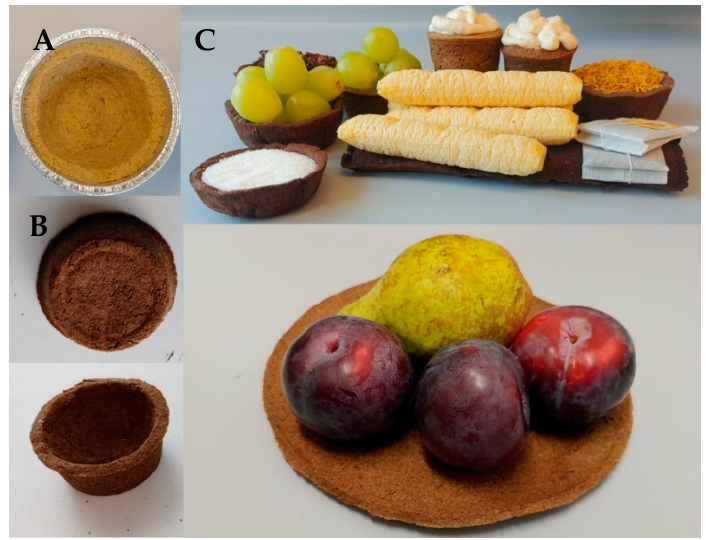
Figure 1. ( A )—formed disposable utensils before baking; ( B )—baked disposable utensils; ( C )—finished disposable dishes in use (own photos).